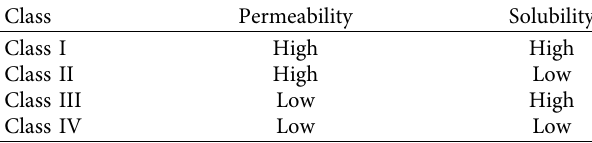
Table 2: Classification of drugs as per the BCS system